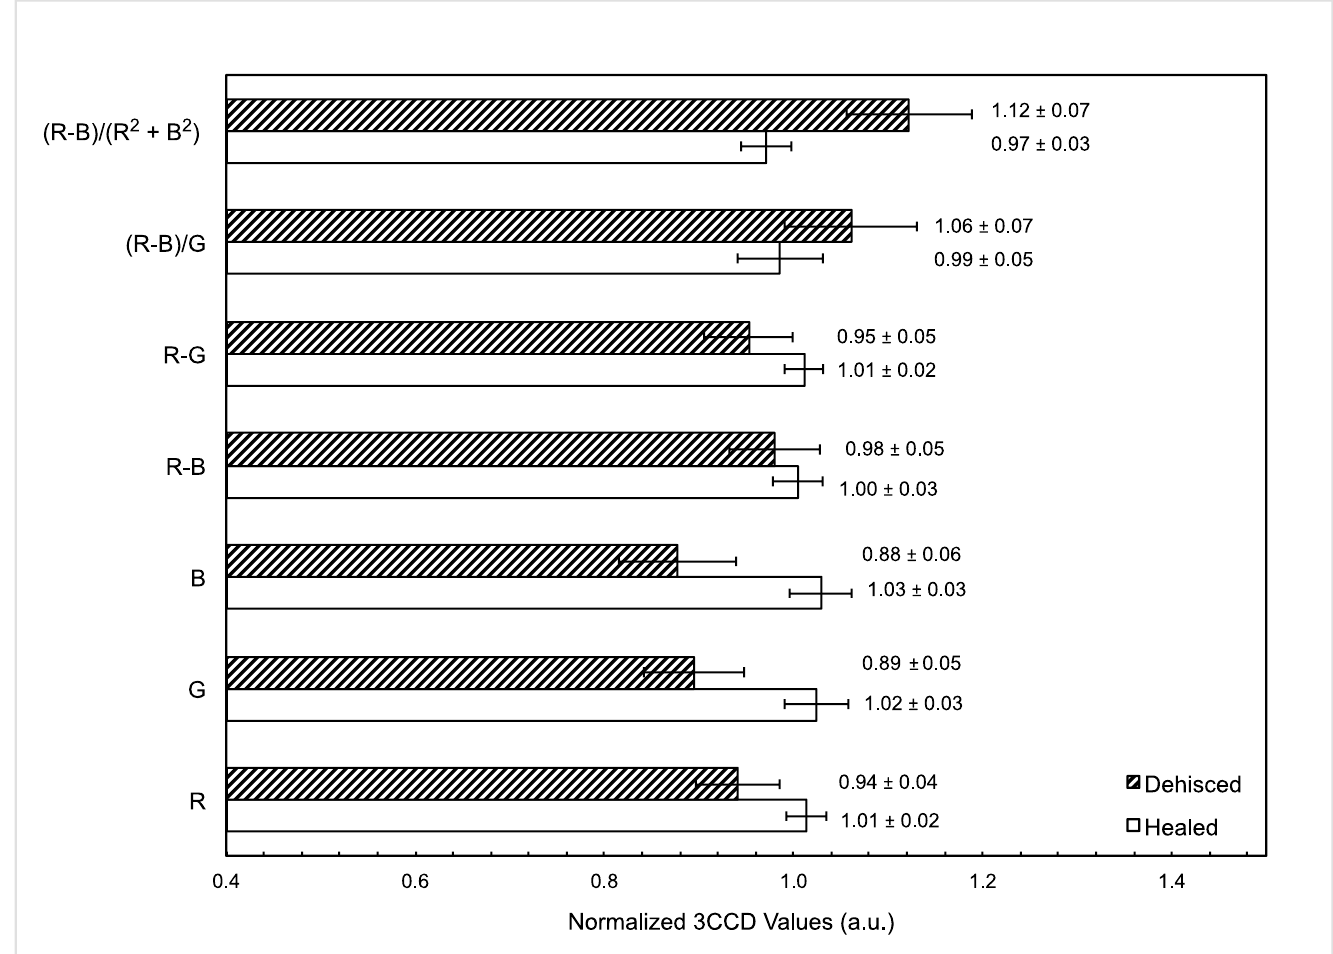
Fig 3. 3CCD values for healed (white bars) and dehisced (striped bars) wounds with mean and standard error of the mean. Adjusted p-values for the imaging variables are 0.123, 0.178, 0.091, 0.854, 0.194, 0.112, and 0.112 for normalized R, G, B, R-B, R-G, (R-B)/G, and (R-B)/(R 2 +B 2 ) values, respectively.